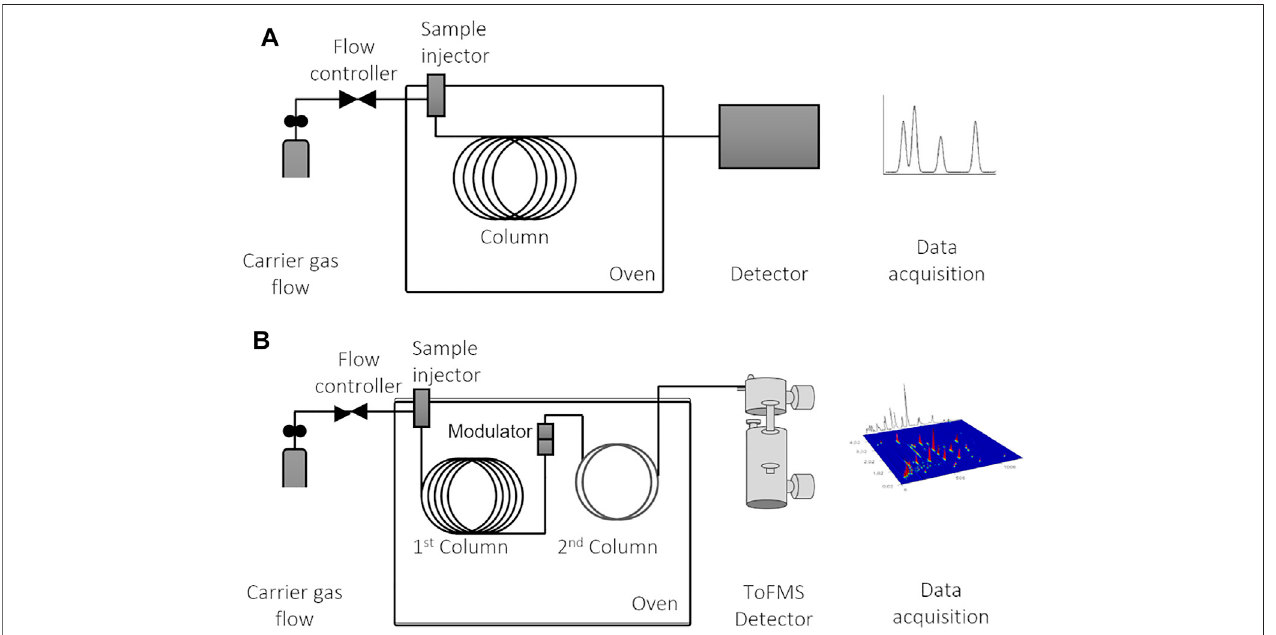
FIGURE 6 | Schematic illustrations of (A) one-dimensional gas chromatographic system (1D-GC), which can be coupled with various types of detectors; and (B) comprehensive two-dimensional (GC × GC) gas chromatographic system coupled with ToFMS (time-of- fl ight mass spectrometry). Figure adapted from Martins et al.